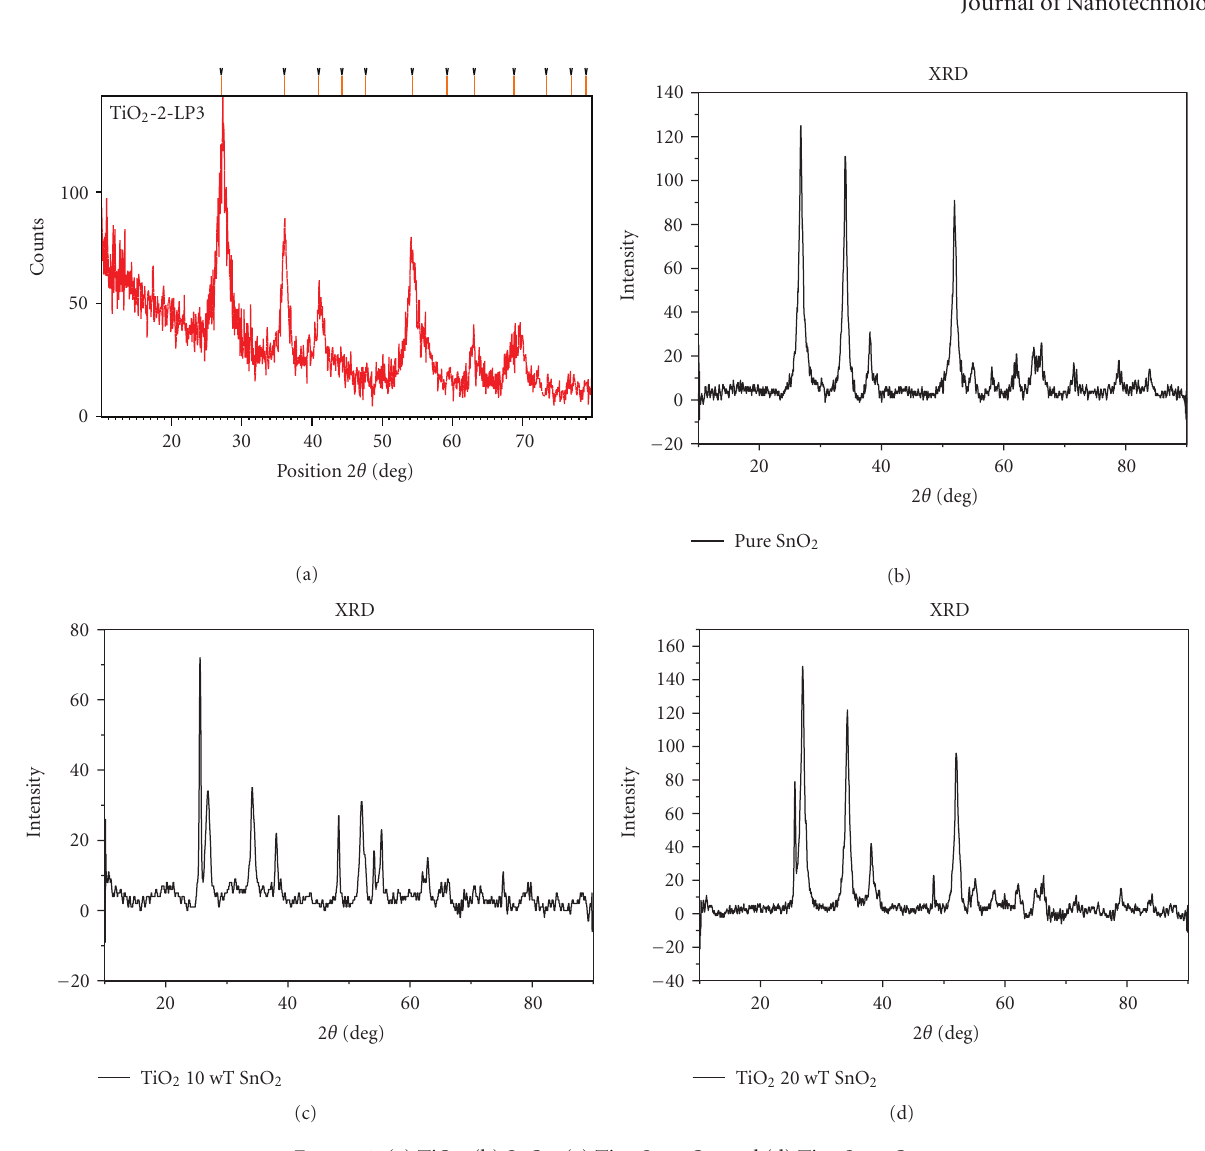
Figure 1: (a) TiO 2 , (b) SnO 2 , (c) Ti 0 . 90 Sn 0 . 10 O 2 , and (d) Ti 0 . 75 Sn 0 . 25 O 2